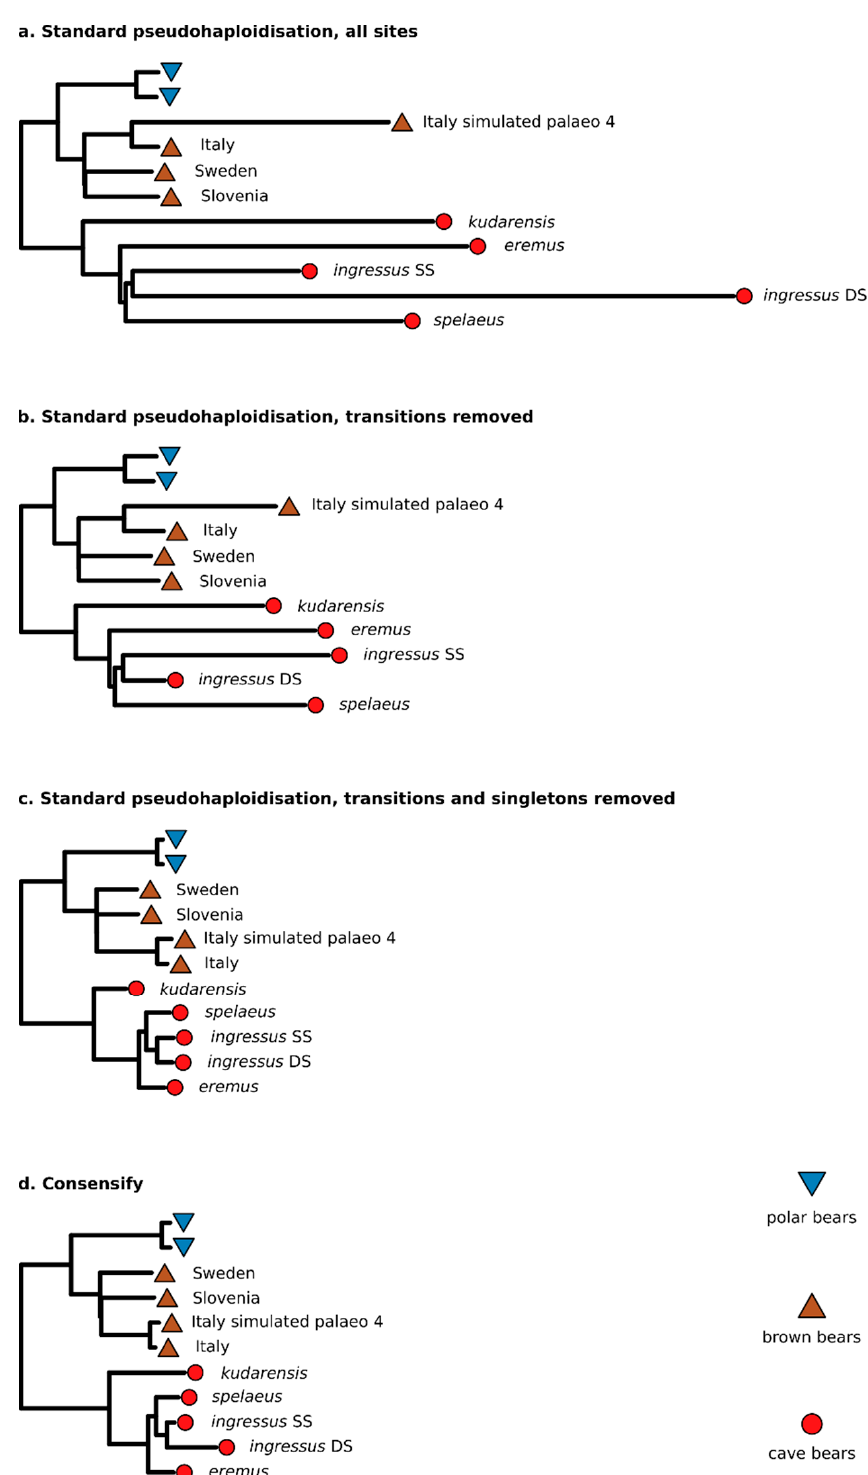
Figure 2. Effect of Consensify on phylogenetic analysis. Panels show neighbour-joining phylogenetic trees calculated from datasets obtained by ( a ) standard pseudohaploidisation using all sites, ( b ) with transitions removed, ( c ) with transitions and singletons removed, and ( d ) Consensify. The trees are rooted using the Asiatic black bear as outgroup (not shown). Coloured symbols at the terminal tips indicate polar bears (blue triangles), brown bears (brown inverted triangles), and cave bears (red circles). The sampling localities of brown bears and the taxon names of cave bears are indicated. “Italy simulated palaeo 4” indicates the simulated palaeogenomic dataset with 35 bp fragment length, cytosine deamination and sequencing error. Note that the ingressus cave bear is represented twice, corresponding to datasets generated from sequencing libraries prepared using a single-stranded (SS) and a double-stranded (DS) protocol, respectively. Absolute branch lengths are not comparable among trees because each dataset includes different numbers of sites filtered in different ways. To improve visualisation of relative differences in branch lengths, the trees have been scaled so that the distance between the basal ingroup node and the terminal tips of the polar